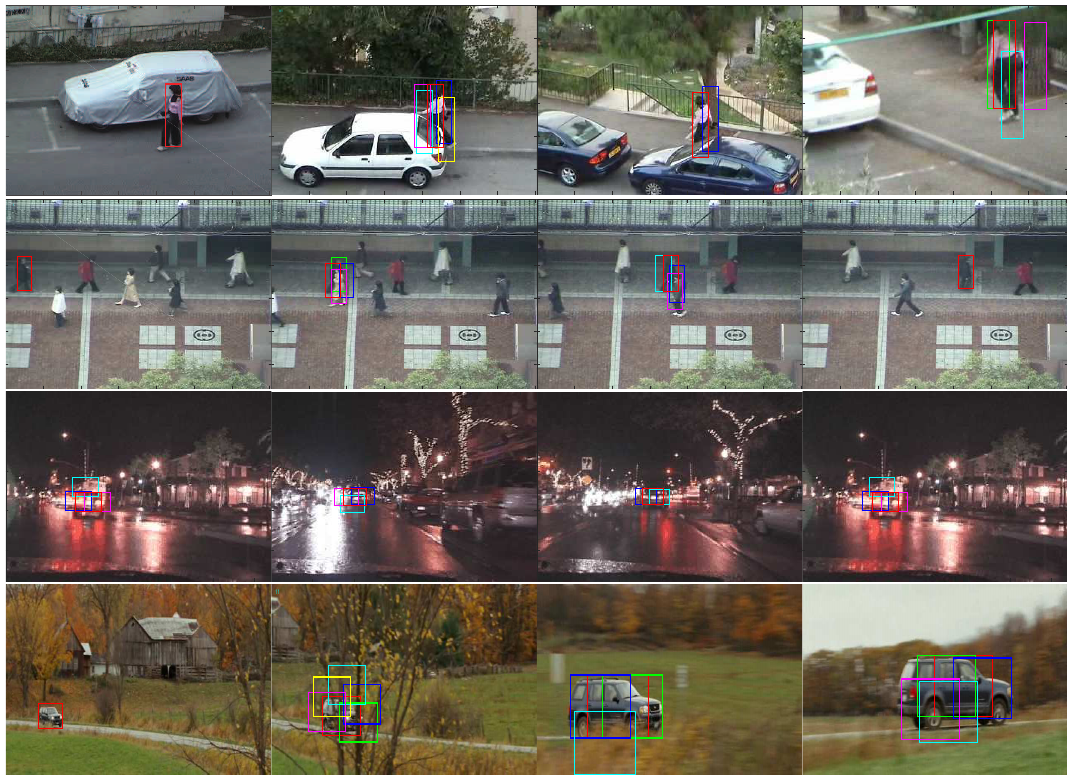
Figure 3. Illustration of the proposed DCF-based region proposal method on four different